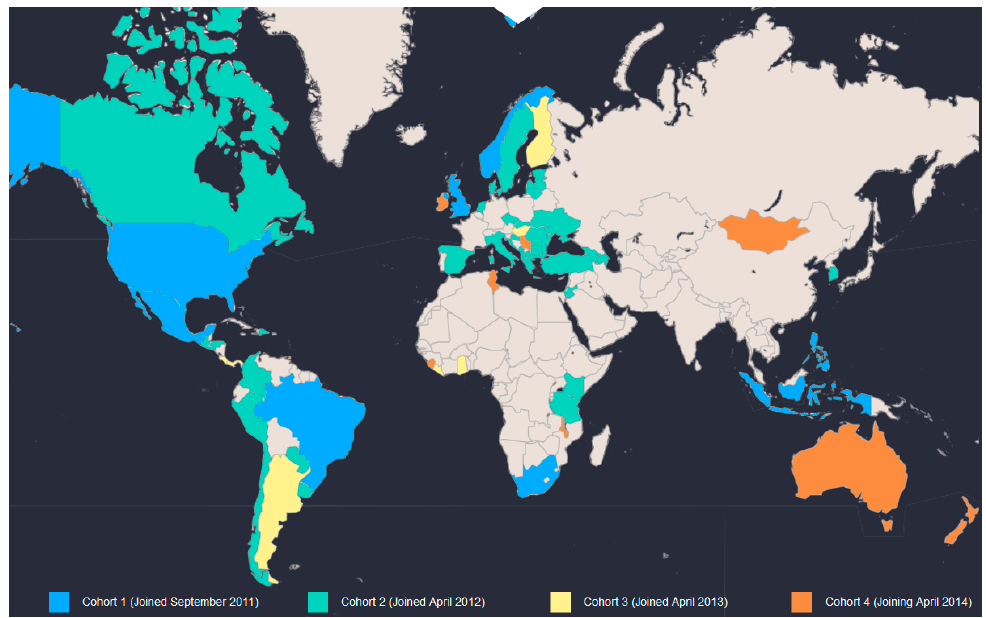
Figure 1. Countries participating in the Open Government Partnership (OGP) [31], CC BY